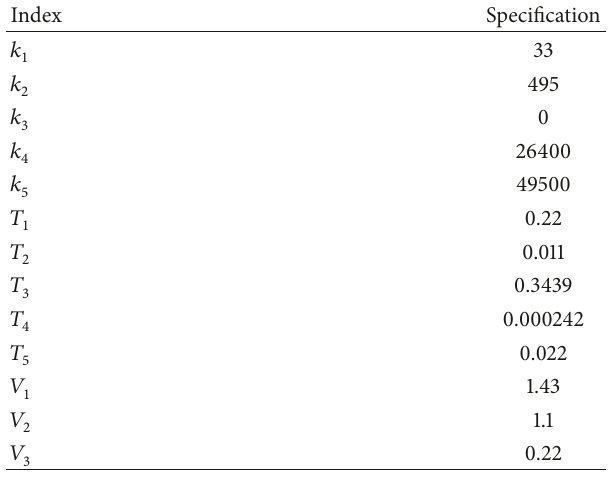
Table 3: Properties of the UTM control algorithm